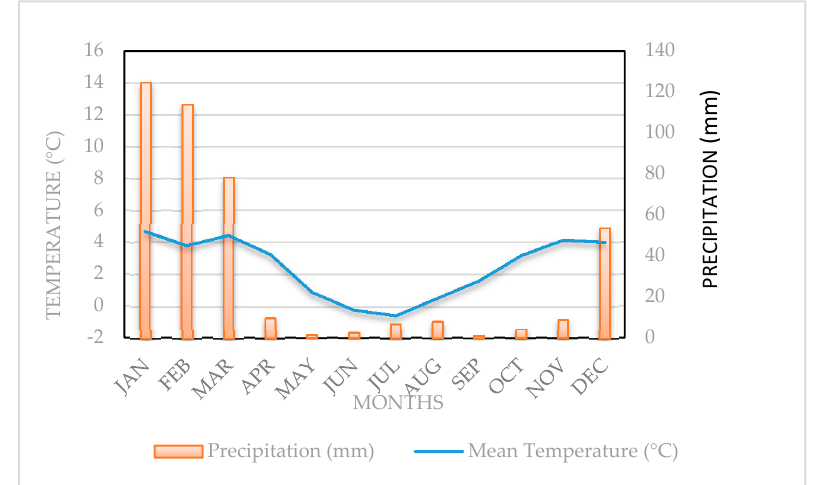
Figure 1. Ombrothermic diagram of Caquena, Putre County, Parinacota, Chile.